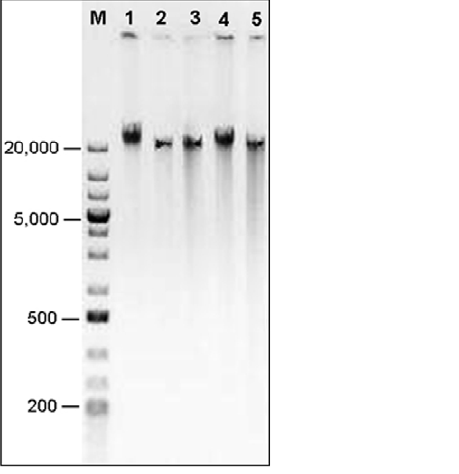
Figure 1. DNA electrophoresis on 0.5% agarose gel at 45 volts for 2 hrs. GeneRuler TM 1 kb Plus DNA markers (M, in bp) and typical DNA samples isolated by SDS (1), CTAB (2), DNAzol H (3), Puregene H (4) and DNeasy H (5).